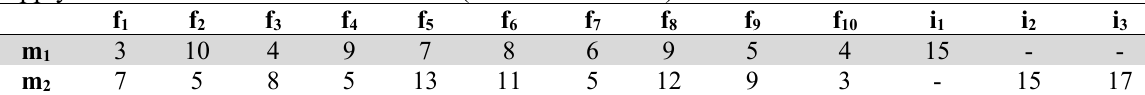
Supply and demand of each raw material (in